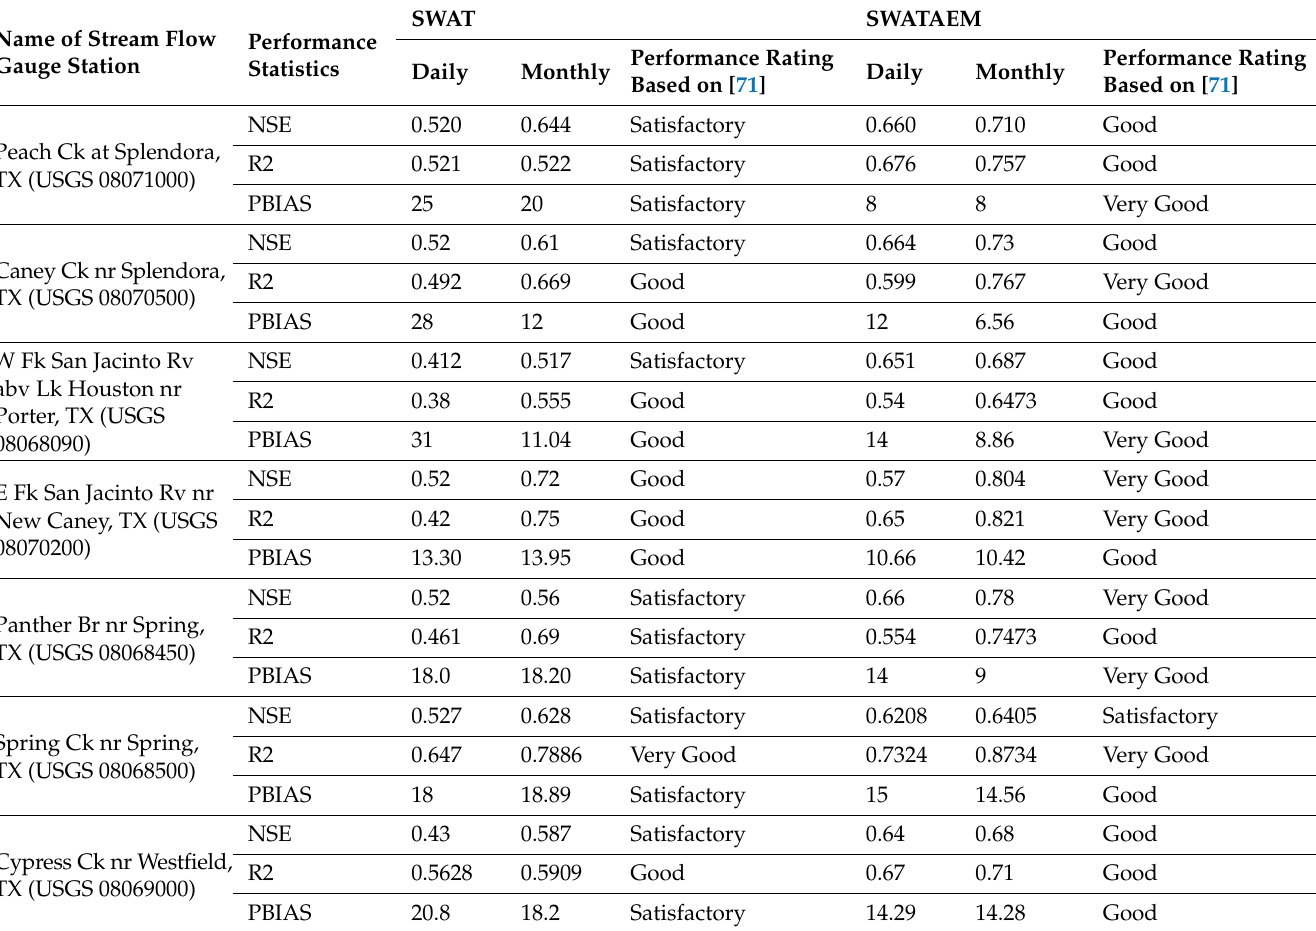
Table 3. Performance statistics between the observed and simulated hydrograph at the stream flow gauge locations for the original SWAT and SWAT AEM